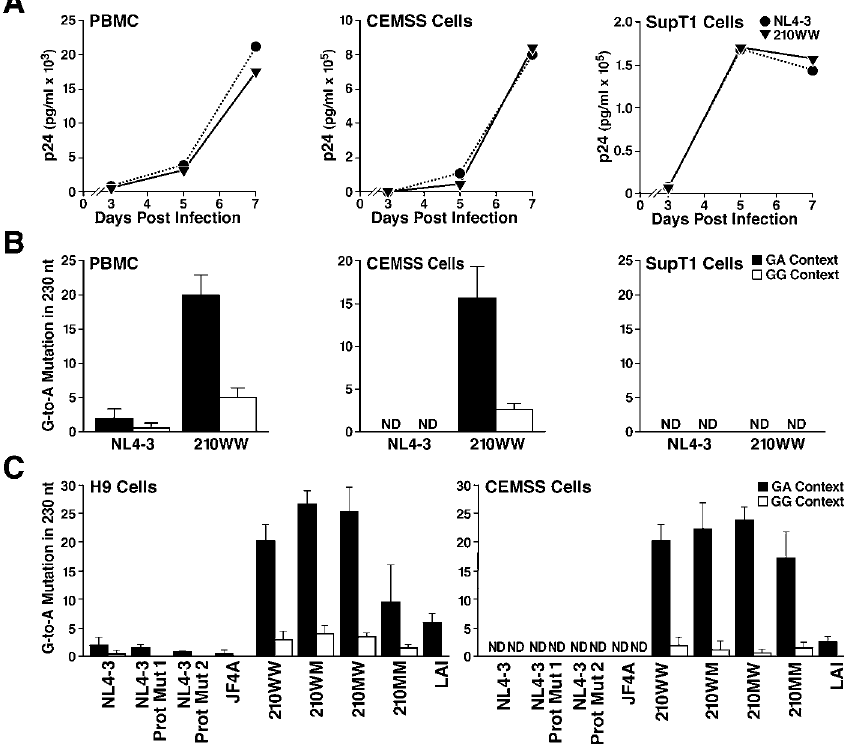
Figure 4. G-to-A Mutation of Wild-Type Virus in PBMC and Different Cell Lines (A) Growth kinetics of 210WW and NL4–3 in PBMC, CEMSS, and SupT1 cells. Cells were infected with p24-normalized viral particles produced from transfected 293T cells. Virus production was monitored by measuring HIV-1 p24 concentration in the culture supernatant. The data presented are one from four independent experiments, in which comparable results were obtained. (B) G-to-A mutation in HIV-1 strains 210WW and NL4–3. DNA was isolated from cell cultures 5 d after infection; the viral protease gene was amplified using the sensitive mutation assay for detecting G-to-A mutated templates. PCR products were then sequenced as a population. The total number of G- to-A mutations in the protease region (positions 2255–2485) was counted separately for the GA and GG contexts. ND, non-detected mutations. (C) Analysis of the GA and GG contexts of the protease gene in the different group of viruses after 7 d of H9 and CEMSS infections. The results presented are the mean and the standard deviations (error bars) of at least three independent infection